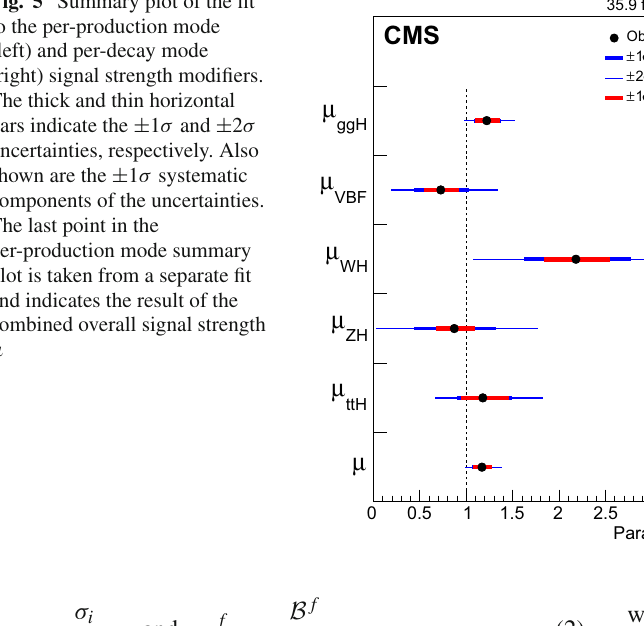
Fig. 5 Summary plot of the fit to the per-production mode (left) and per-decay mode (right) signal strength modifiers. The thick and thin horizontal bars indicate the ± 1 σ and ± 2 σ uncertainties, respectively. Also shown are the ± 1 σ systematic components of the uncertainties. The last point in the per-production mode summary plot is taken from a separate fit and indicates the result of the combined overall signal strength